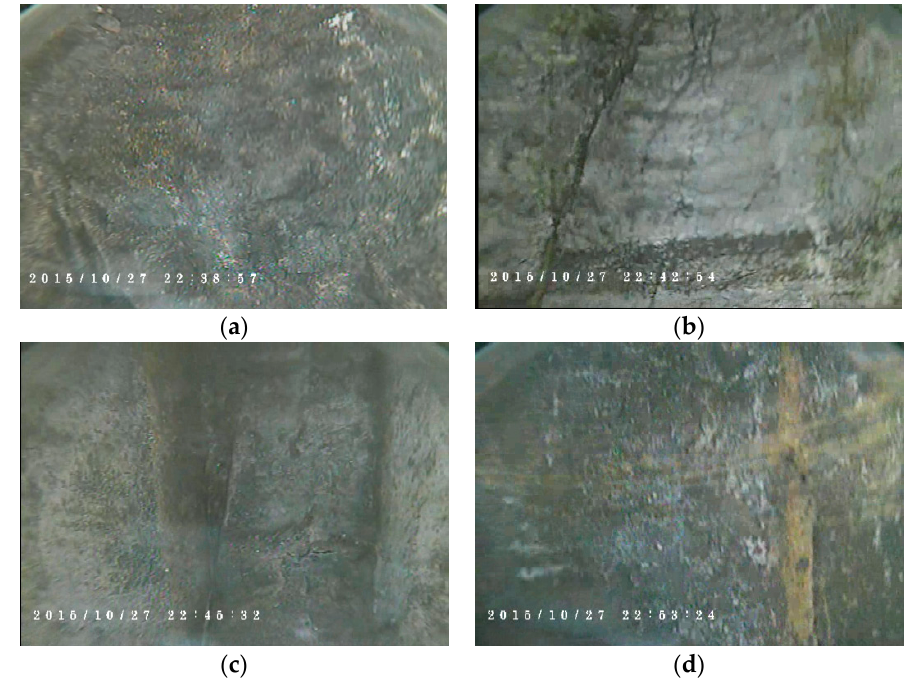
Figure 20. Rock failure with different depths depicted by electronic drilling peep instrument. ( a ) Drill hole depth of 1 m; ( b ) Drill hole depth of 2 m; ( c ) Drill hole depth of 3.5 m; and ( d ) Drill hole depth of 4.5 m.